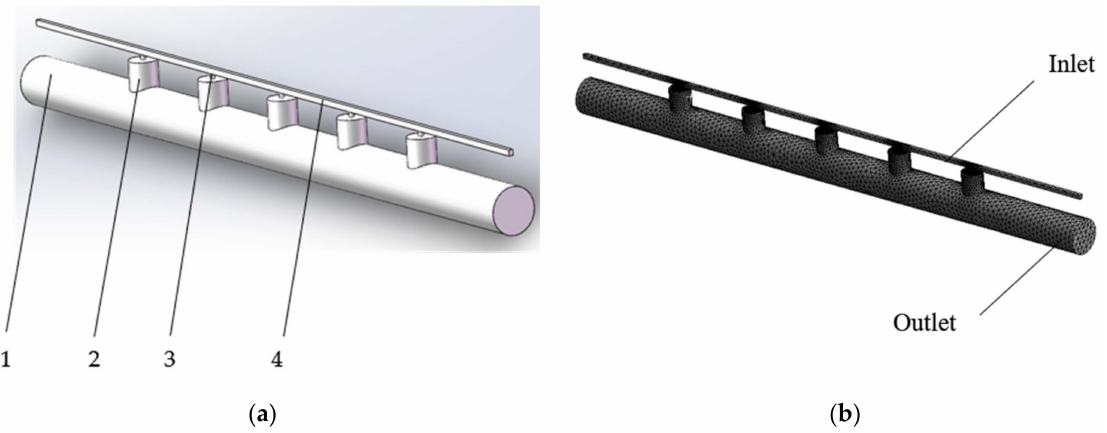
Figure 4. ( a ) The physical model and meshing of airflow in negative pressure zone. 1. Airflow field in negative pressure cavity; 2. Airflow field in big suction hole; 3. Airflow field in small suction hole; 4. Airflow field outside the suction hole; ( b ) The meshing of